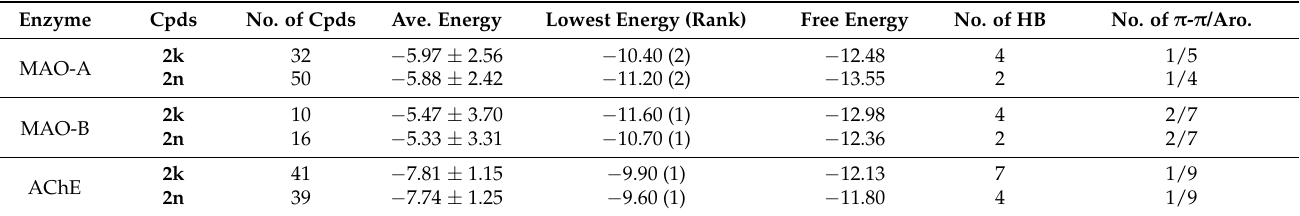
Figure 8. Molecular docking of 2k and 2n on MAO-A, MAO-B, and AChE. ( A ) Superimposed MAO family structure. Both structures are drawn by Cartoon model shaded by blue (MAO-A) and red color (MAO-B). The catalytic regions are drawn by transparent yellow surface model in the center. ( B ) Pocket and catalytic region of MAOs. The protein model is drawn by white surface model. MAO family structure has large pocket (blue surface model) in the center and connected to the catalytic region (red circle) in the center. The pocket has two entrances toward the catalytic regions (two blue arrows). ( C ) AChE protein structure drawn by blue cartoon model and yellow transparent surface model (catalytic region). The compound entrances toward the catalytic region are indicated by blue arrows. Docking simulation results of compounds 2k and 2n into MAO-A ( D ), MAO-B ( E ), and AChE ( F ). The MAOs structures are sketched by white sphere model and the binding pockets that exist on the center are shaded by blue color. The below panels show the binding pocket shade by transparent blue spheres for the existing compound to show. The binding catalytic regions are shown by transparent yellow colors. The compounds are bound in the pocket and near the catalytic region. Table 3. Detailed docking results of compounds 2k and 2n on MAO-A, MAO-B, and AChE a